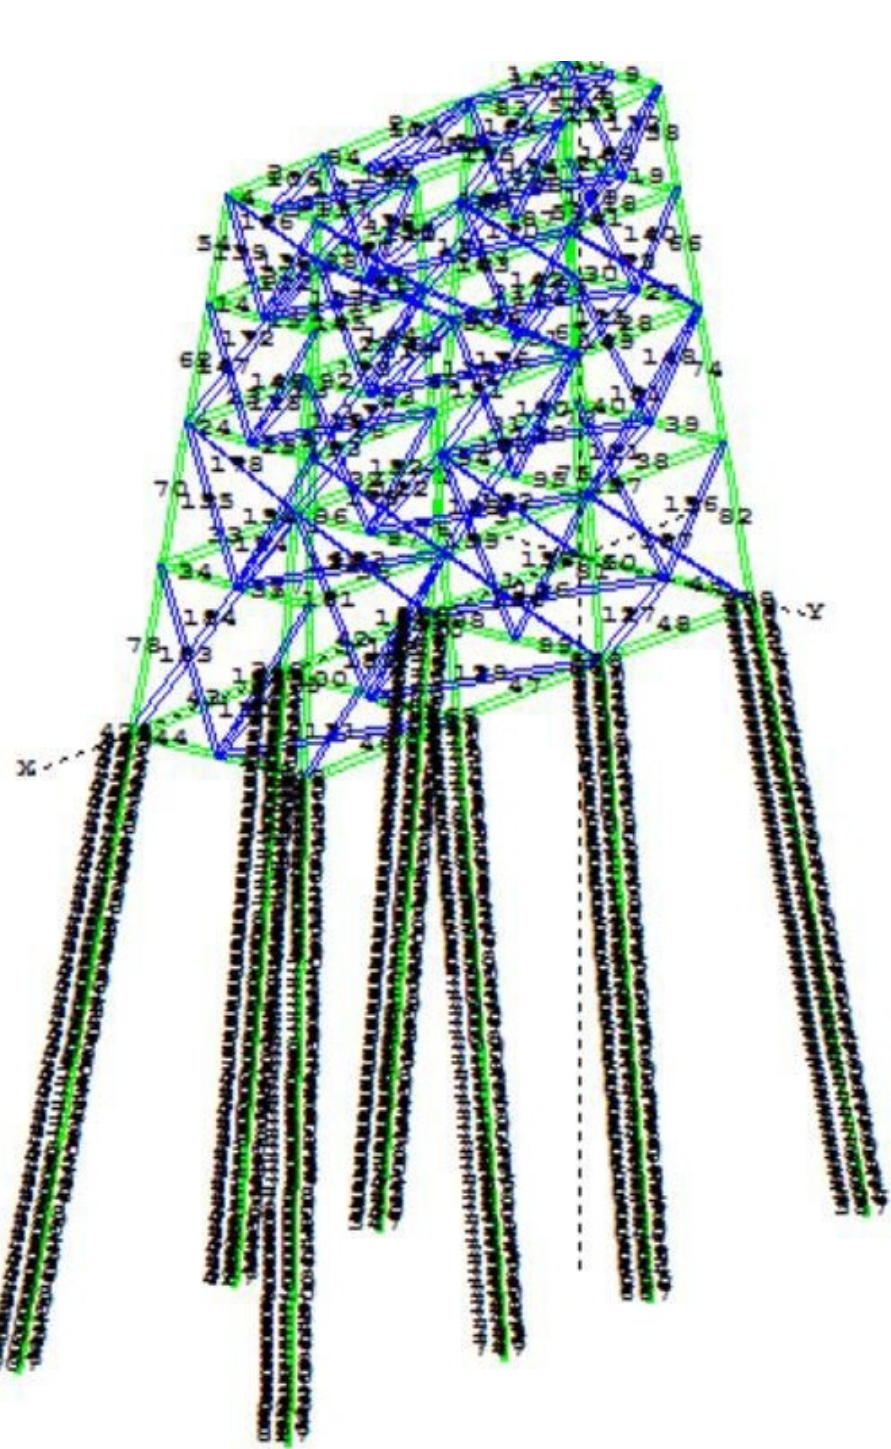
Figure 2. Three-dimensional view of a jacket platform based on deformable soil (soil – pile – platform system). Table 1. Cross sections of the platform’s tubular members.